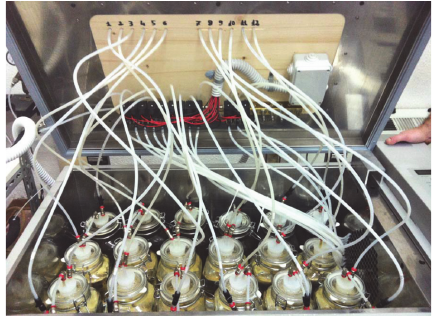
Figure2:Environmentalchamberoftheexperimentalapparatusset at 58 ± 2 ∘ C.